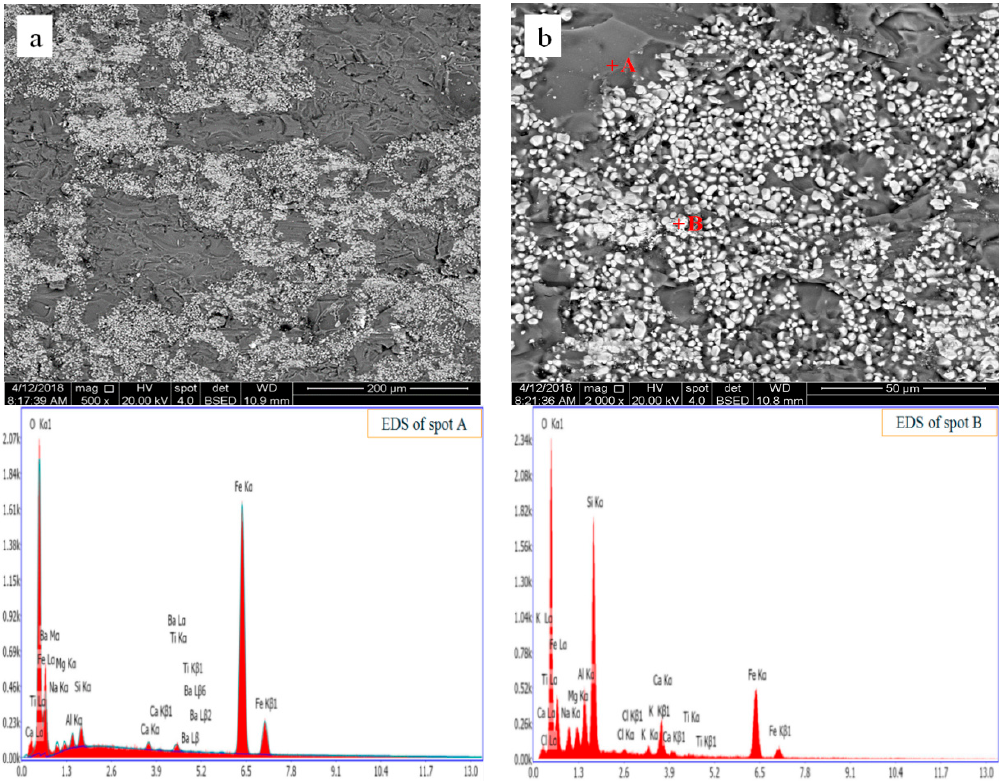
Figure 10. SEM-EDS images of CT after chlorination roasting in the microwave field. ( a ): low magnification image; ( b ): magnified image of local area in ( a ).